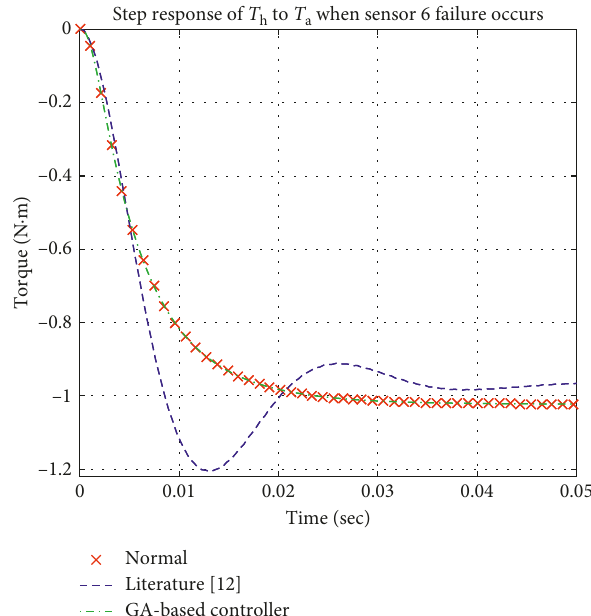
Figure 8: The step response of EPS system with the failure of sensor